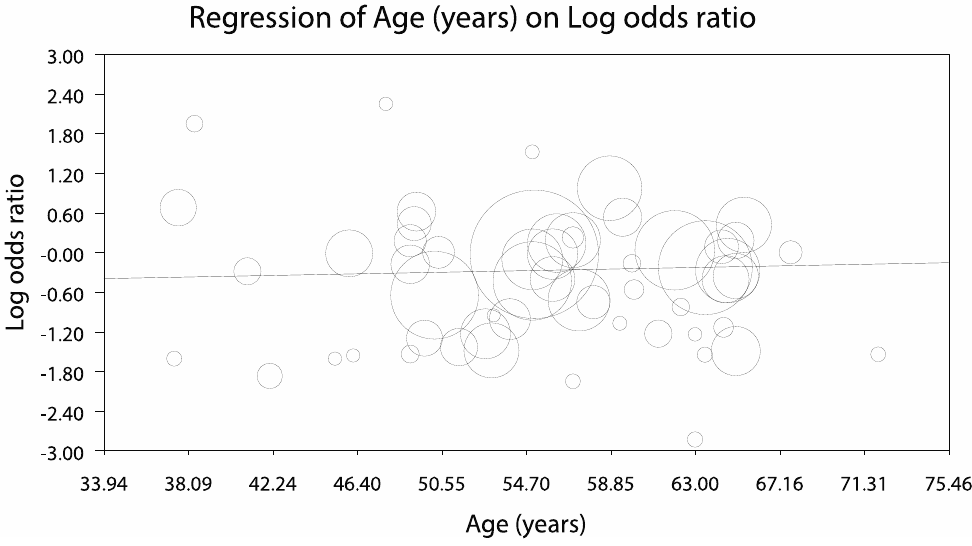
Figure A2. Meta-regression showing the impact of age distribution on Log odds ratio.